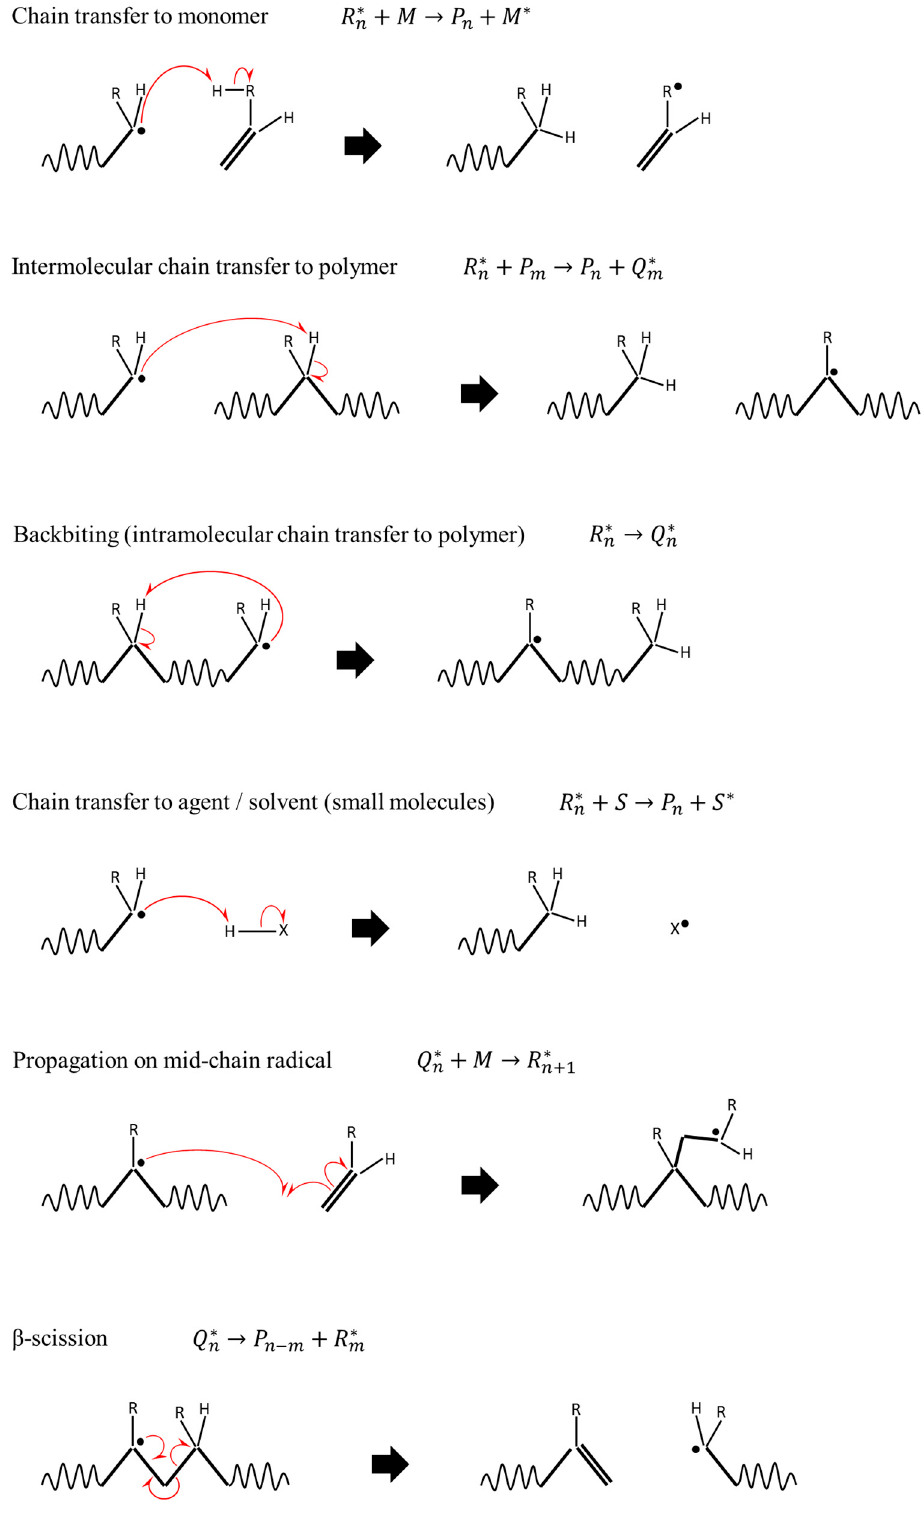
Figure 3. Schematic representation of relevant secondary reactions. R , terminal radical; M , monomer; P , dead polymer; Q , mid-chain radical.